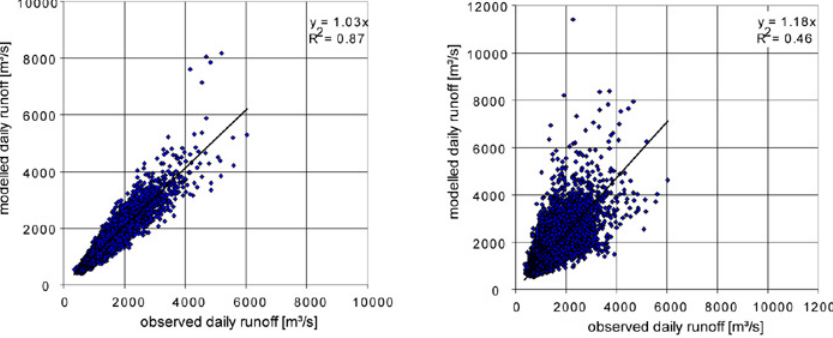
Figure 6. Comparison of observed and modelled daily runo ff at the UDRB outlet gauge in Achleiten for 1971–2000, using station recordings (left) and downscaled CLM ERA output data (right).